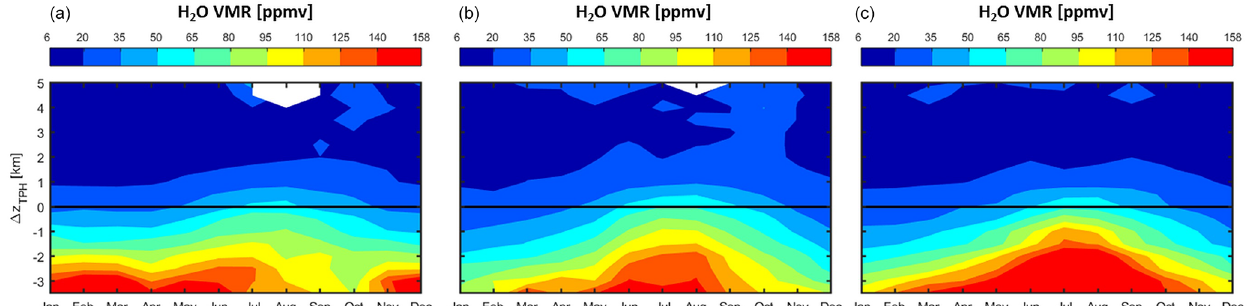
Figure 6. The 15-year averaged annual cycles of H 2 O VMR vertical distributions of H 2 O VMR for latitudes 40 to 60 ◦ N and for the regions of (from a to c ) eastern North America (105 to 65 ◦ W), the North Atlantic (65 to 5 ◦ W) and Europe (5 ◦ W to 30 ◦ E).